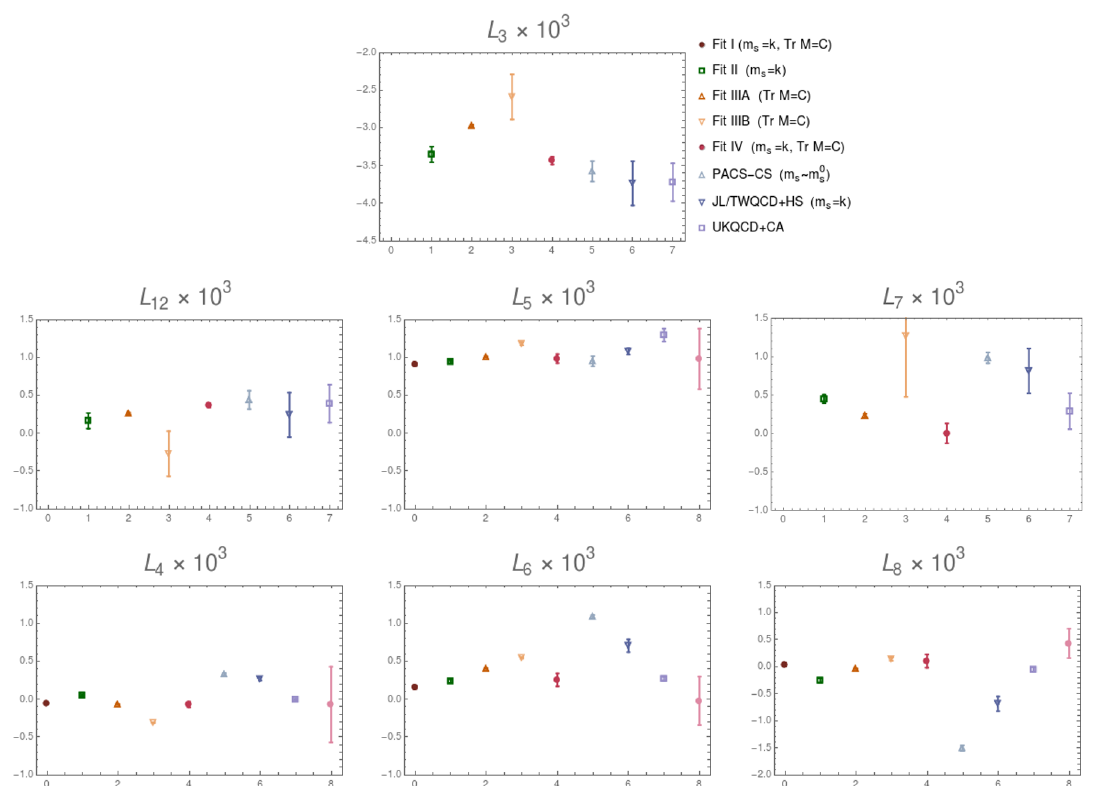
Figure 38 . Values of the LECs obtained in the several combined and global (cid:12)ts. For comparison purposes, in the case of L 4 , L 5 , L 6 and L 8 we also include the corresponding FLAG average value (last data point in